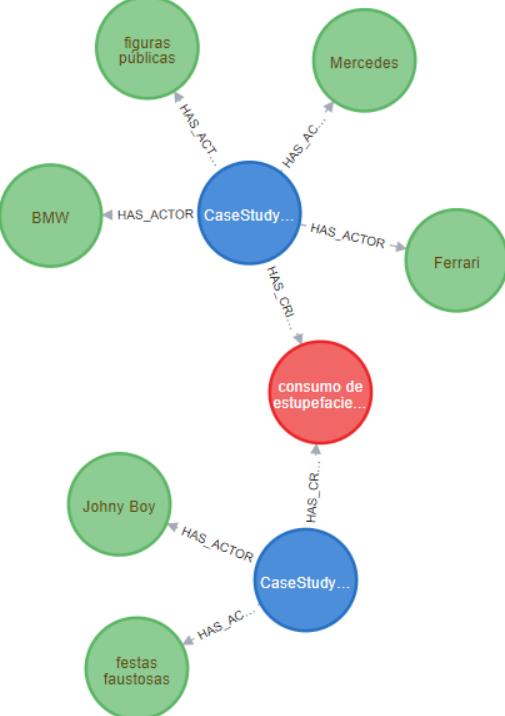
Figure 9. Cypher Query Output (Question 1).